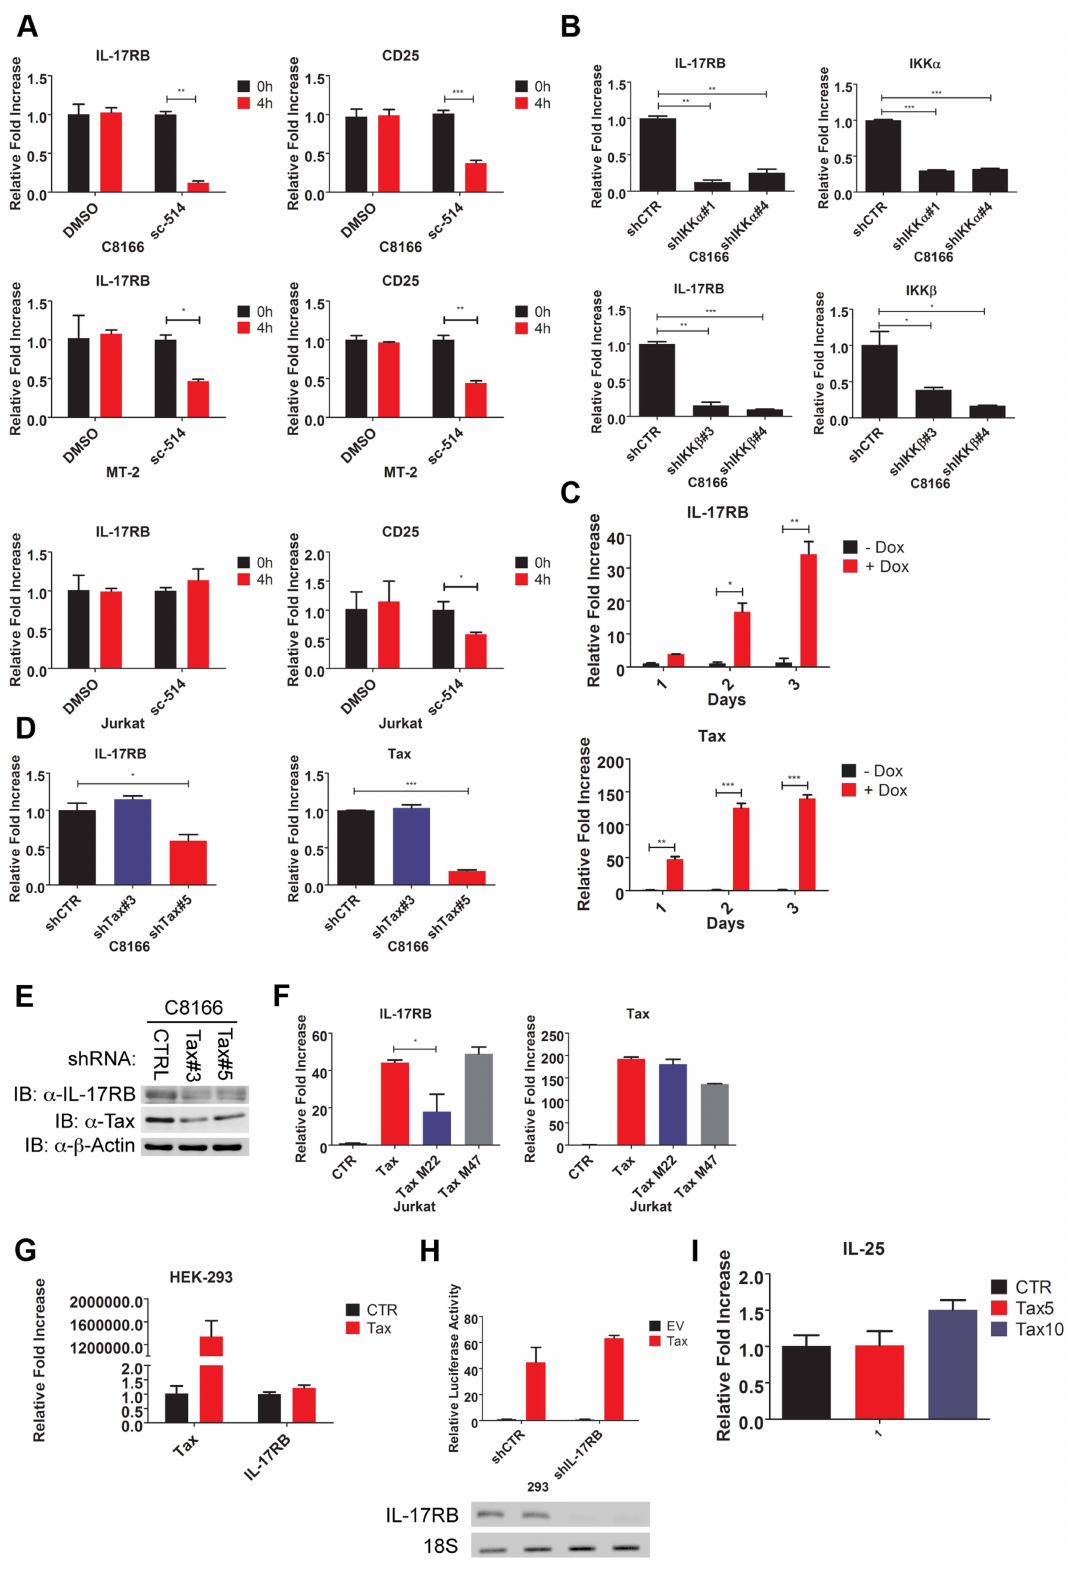
Figure 2. Essential roles for IKK and Tax in the induction of IL-17RB. ( A ) qRT-PCR of IL-17RB and CD25 mRNAs in C8166, MT-2 and Jurkat cells treated with the IKK b inhibitor sc-514 (10 m M) for 4 h. ( B ) qRT-PCR of IL-17RB, IKK a and IKK b mRNAs in C8166 cells transduced with lentiviruses expressing control, IKK a or IKK b shRNAs. ( C ) qRT-PCR of IL-17RB and Tax mRNAs in Jurkat Tax Tet-On cells treated with Dox (1 m g/ml) for the indicated times. ( D ) qRT-PCR of IL-17RB and Tax mRNAs in C8166 cells transduced with lentiviruses expressing control or Tax shRNAs. ( E ) Western blot